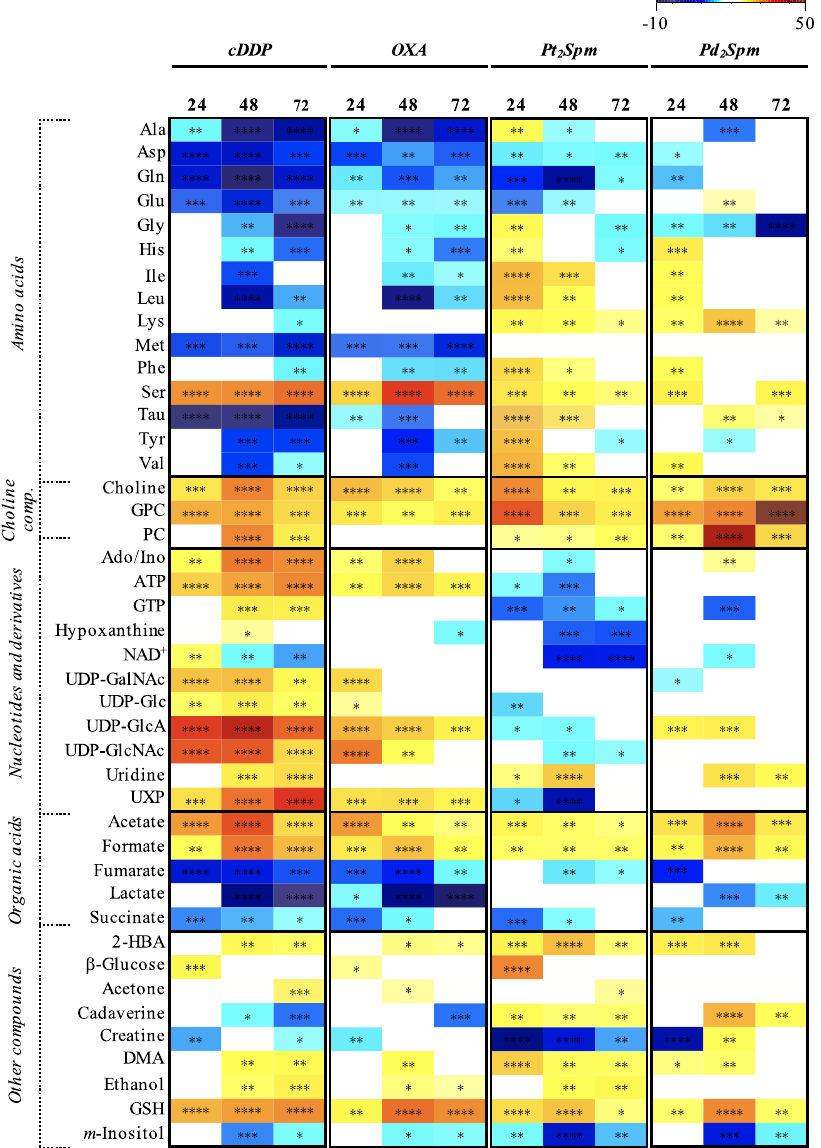
Figure 4. Heatmap of metabolites variations in aqueous extracts of MG-63 cells exposed to metal, in relation to controls (each time point was compared against the same time point of controls). The ES color-coded scale indicates increases and decreases of metabolite levels, in hot and cold colors, respectively. Inclusion criteria: |ES| > 0.50 and error < ES. ✽ p -value < 0.05; ✽✽ p -value < 0.01; ✽✽✽ p -